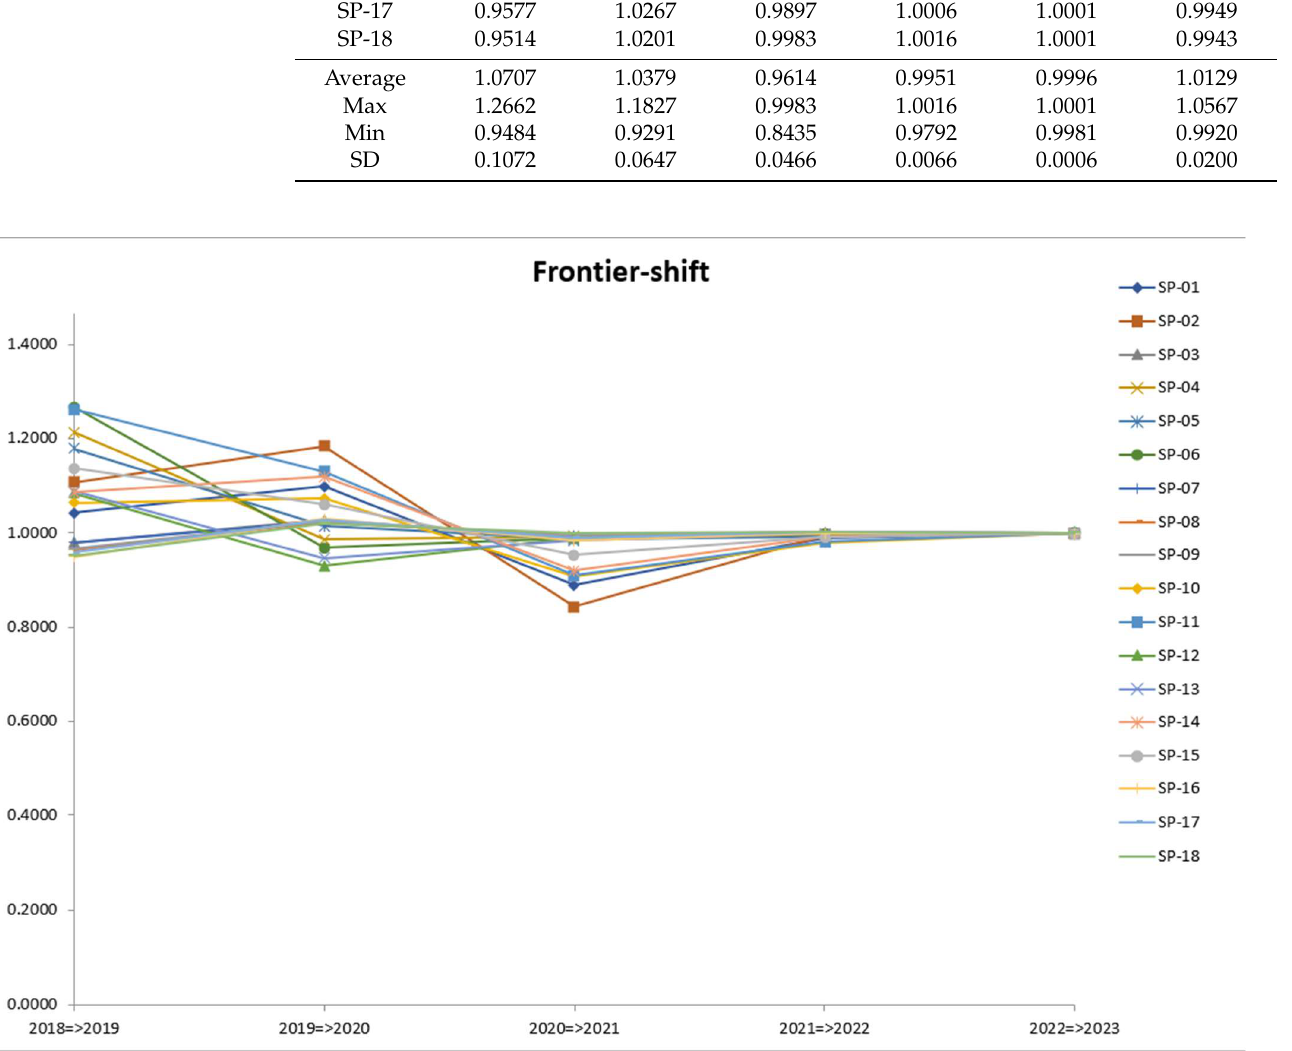
Figure 3. Technological change (frontier-shift).